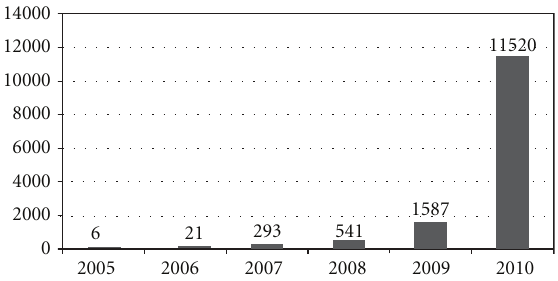
Figure 9: Cases of dengue fever in SD Venda Nova from 2005 to 2010.